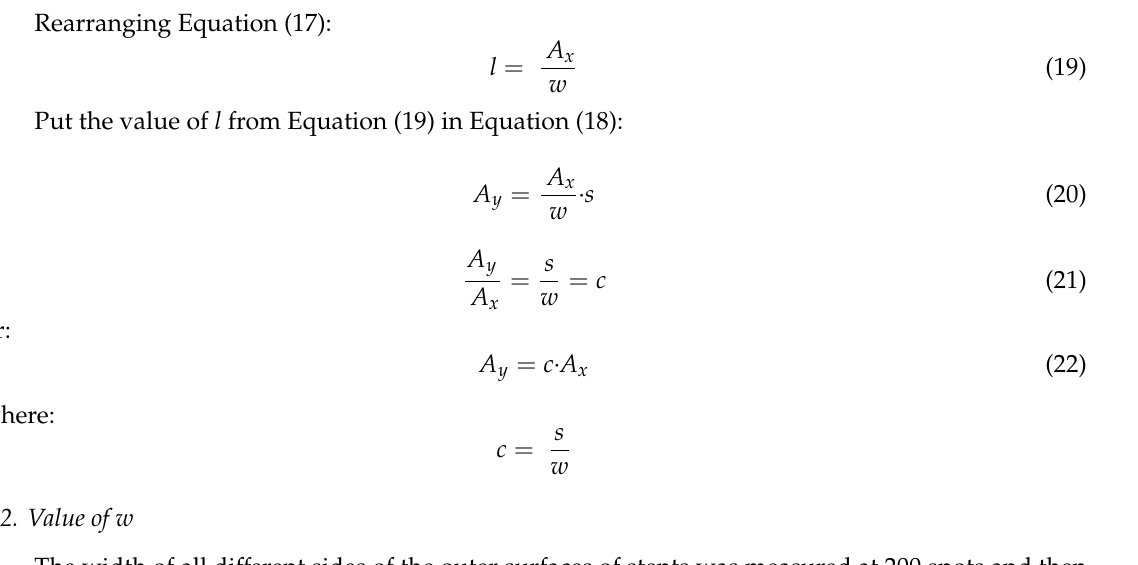
Figure 3. Part of stent wire with length l , width of outer surface w , and strut thickness s . The three sides of this rectangular block are s , l , and w . A x is the area of surface 1 with sides w and l . A y is the area of surface 2 with sides s and l .